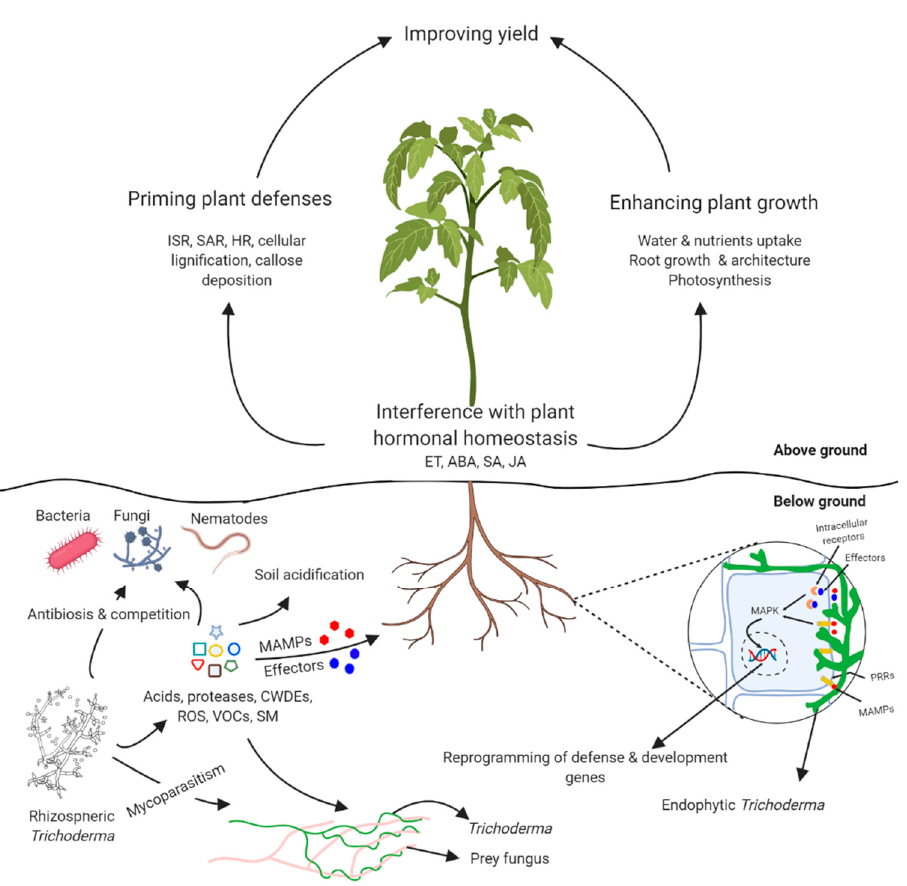
Figure 1. Trichoderma– plant–pathogen interactions map. Trichoderma produces recognition molecules, i.e., MAMPS (microbe-associated molecular patterns) and effectors, which bind to the PRRs (pattern recognition receptors) and intracellular receptors activating mitogen-activated protein kinase (MAPK) cascades, leading to the reprogramming of several plant pathways related to defense, i.e., induced systemic resistance (ISR), systemic acquired resistance (SAR), and hypersensitive response (HR), as well as interfering with hormonal homeostasis, i.e., ethylene (ET), abscisic acid (ABA), salicylic acid (SA), and jasmonic acid (JA) pathways. Trichoderma -pathogen interactions takes several forms through the action of its diverse secretome containing volatile organic compounds (VOC), cell wall degrading enzymes (CWDE), reactive oxygen species (ROS), and antimicrobial secondary metabolites (SM). By forming these interactions, Trichoderma increases plant fitness and tolerance against biotic stress either by priming plant defenses, increasing plant growth, or releasing pathogen pressure leading to the enhanced growth response.